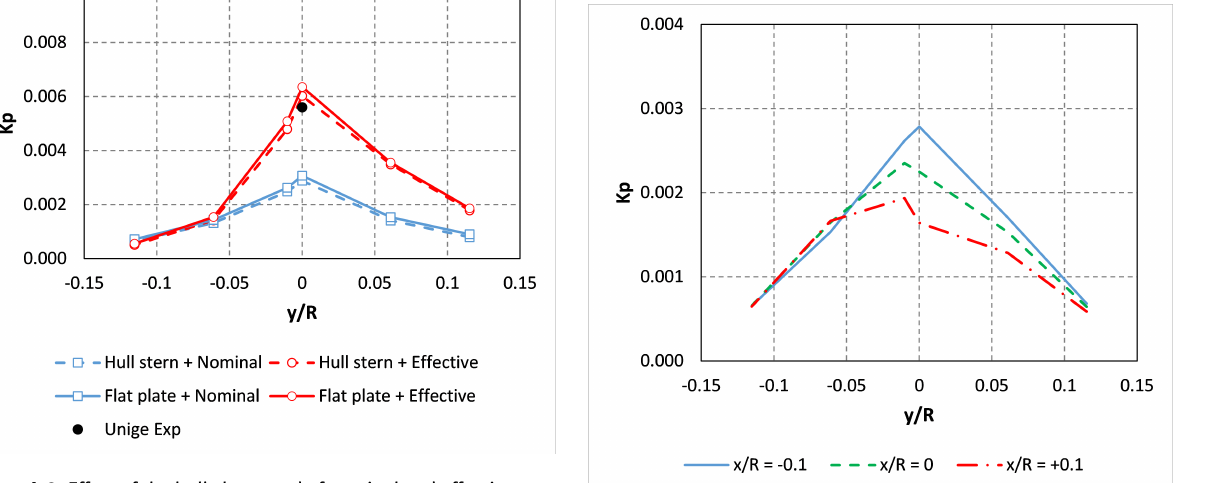
Figure A.2: Effect of the hull shape and of nominal and effective wakes in correspondence of different transversal point at longitudi- nal propeller plane position. Third harmonic values.